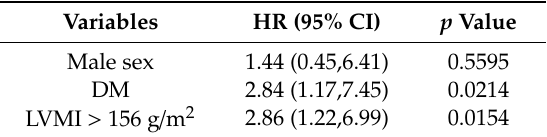
Table 2. Adjusted hazard ratio for CV events.